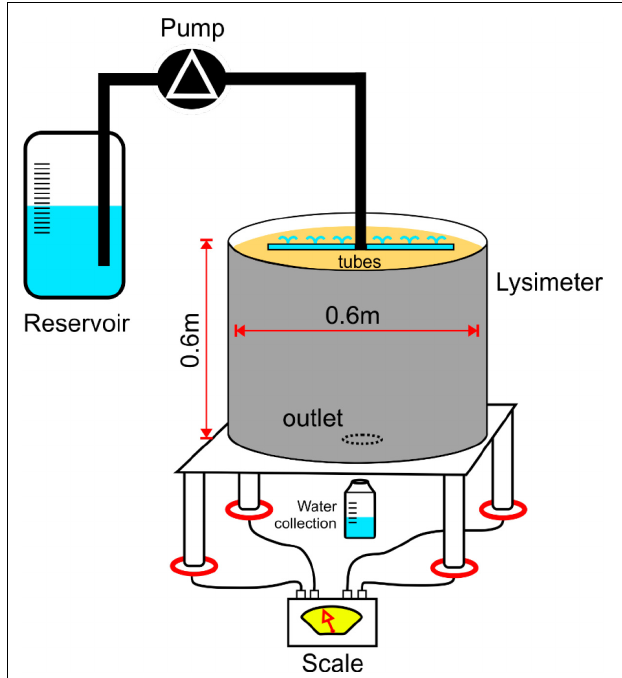
FIGURE 1 | Setup of the lysimeter